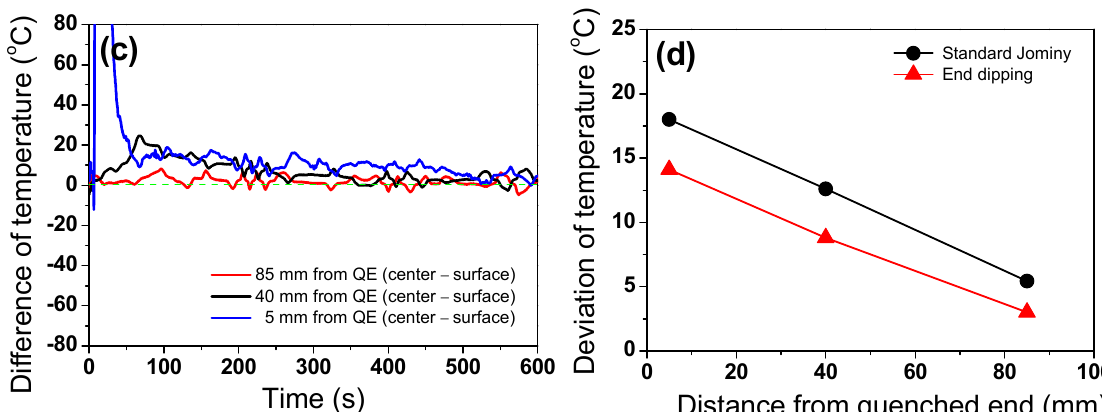
Figure 10. ( a ) Temperature profiles of the Jominy specimen with end dripping (ED) cooling condition, ( b ) comparison of temperature profiles at the center areas between the SH and ED specimen, ( c ) temperature difference between center and surface area of the ED specimen with cooling time and region, and ( d ) comparison of the standard deviation of temperature between the SH and ED specimen with region.